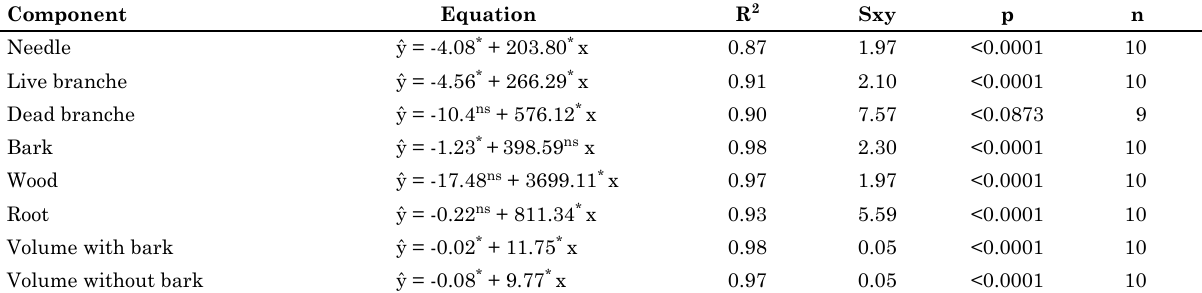
table 2. equations for estimating wood volume (with and without bark) and for biomass of tree components in 16-year-old Pinus taeda collected in otacílio costa, Sc, brazil component